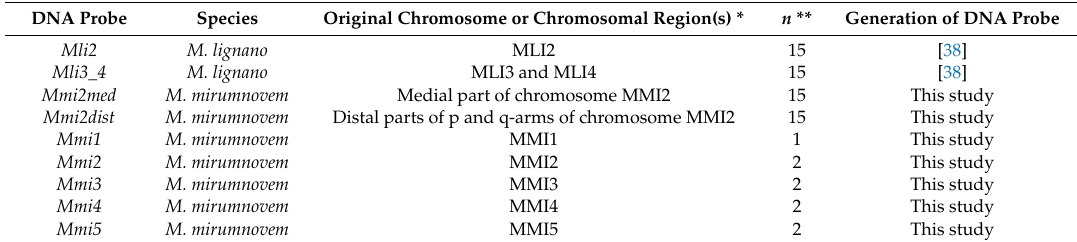
Table 3. Microdissected region- and chromosome-specific DNA probes used in this study. DNA Probe Species Original Chromosome or Chromosomal Region(s)